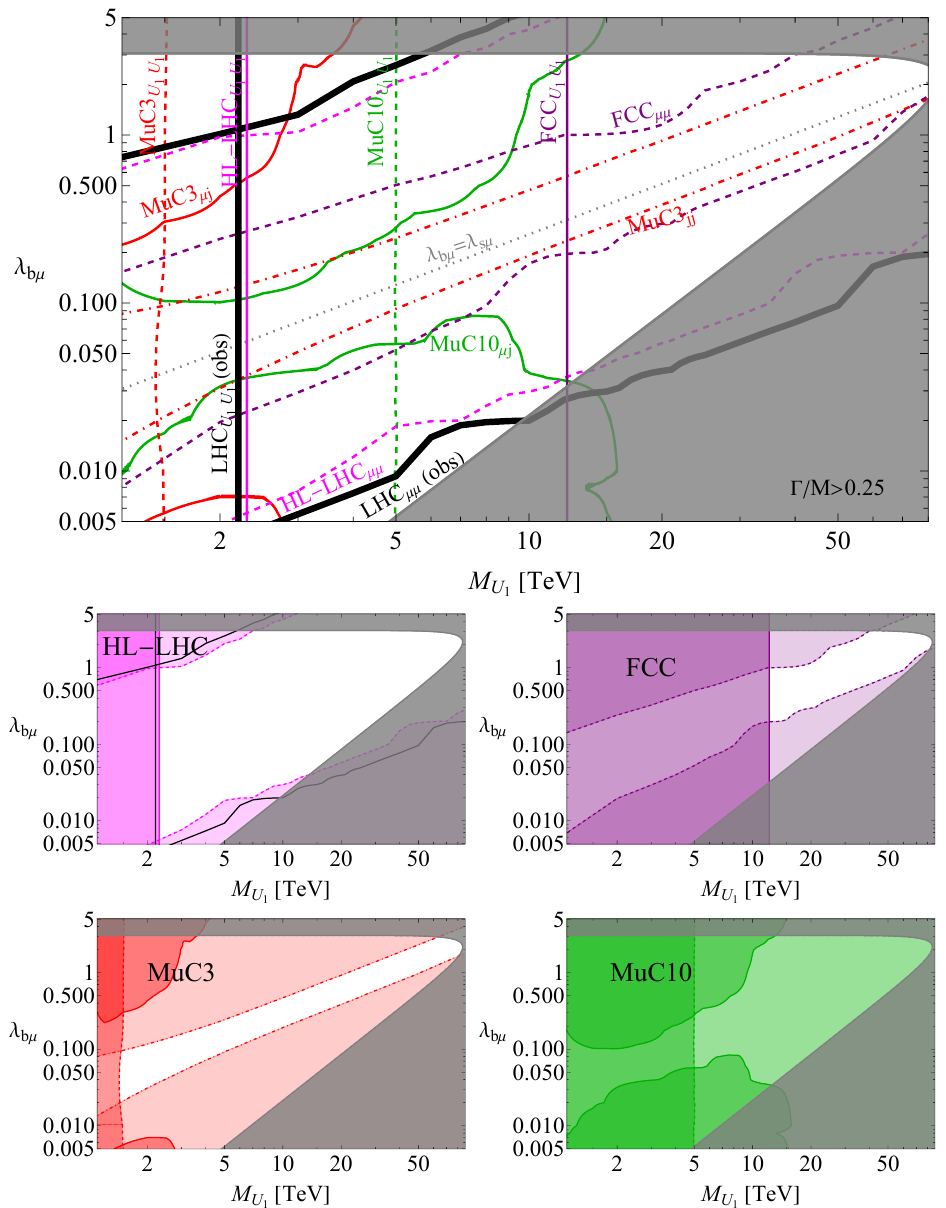
Figure 16 . Discovery reach at 5 σ for the U 1 leptoquark. The fit to bsµµ anomalies is imposed everywhere via eq. (6.6). The present 95%CL exclusion by LHC is shown as a thick black line. The dotted gray line corresponds to λ bµ = λ sµ . In the grey region, the perturbativity criterion Γ U /M U < 0 . 25 is violated. The limit for the µ ¯ µ → jj channel at 10 TeV MuC covers the whole 1 1 plane. For future colliders, the discoverable region is the one on the side of the line where the corresponding label has been drawn. The smaller figures below the main figure highlight a single future collider at a